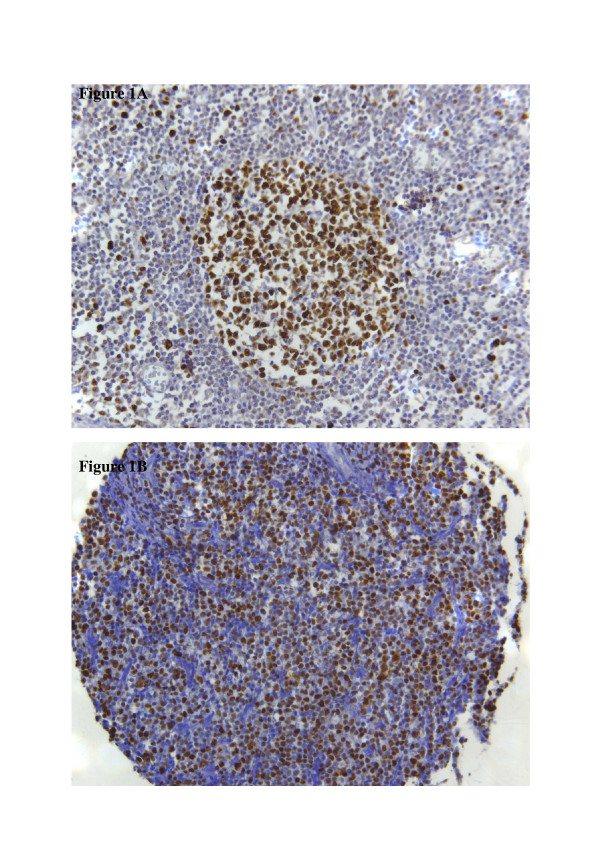
Immunohistochemistry. Figure 1A: Immunohistochemical staining of Mcm2 in a non-neoplastic lymph node. Mcm2-expression is found in the majority of cells in the germinal centre; only a few cells in the mantle zone are positive for Mcm2. Figure 1B: Immunohistochemical staining of Mcm2 in diffuse large B-cell lymphoma. This case is positive for Mcm2-expression with more than 40% of tumour cells expressing this marker.